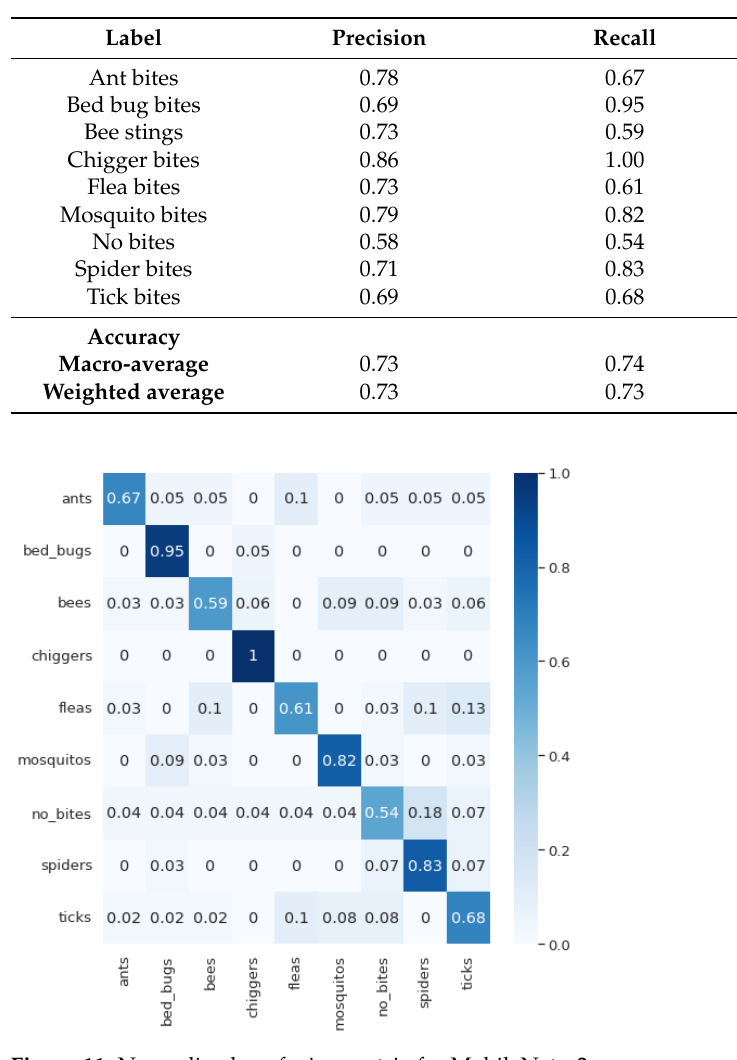
Table 10. Evaluation metrics for MobileNet-v2 model.